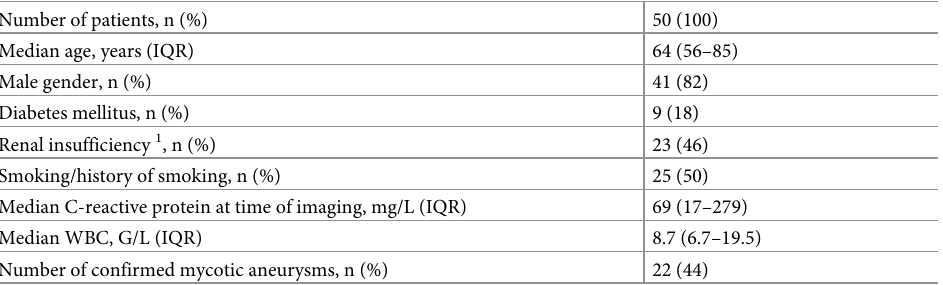
Number of confirmed mycotic aneurysms, n